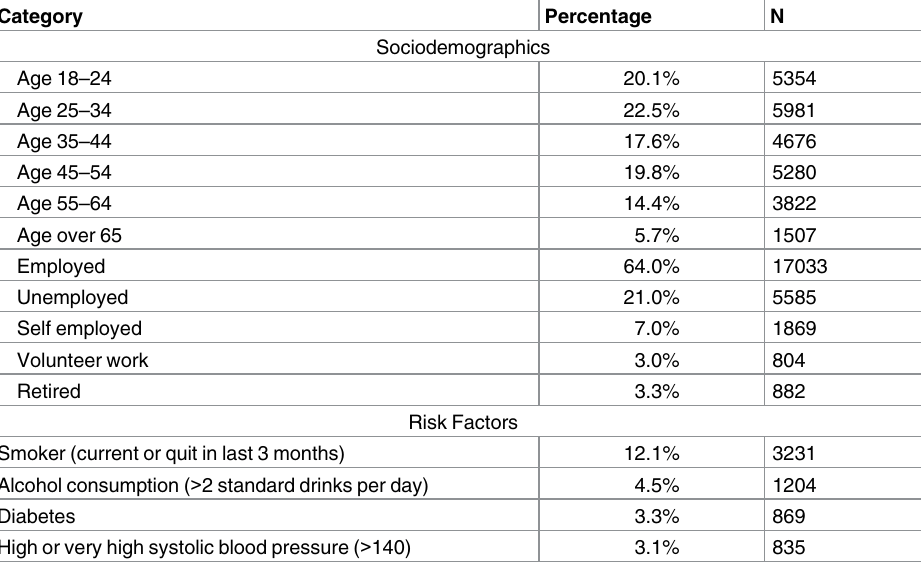
Table 3. Characteristics of the women who completed the online health